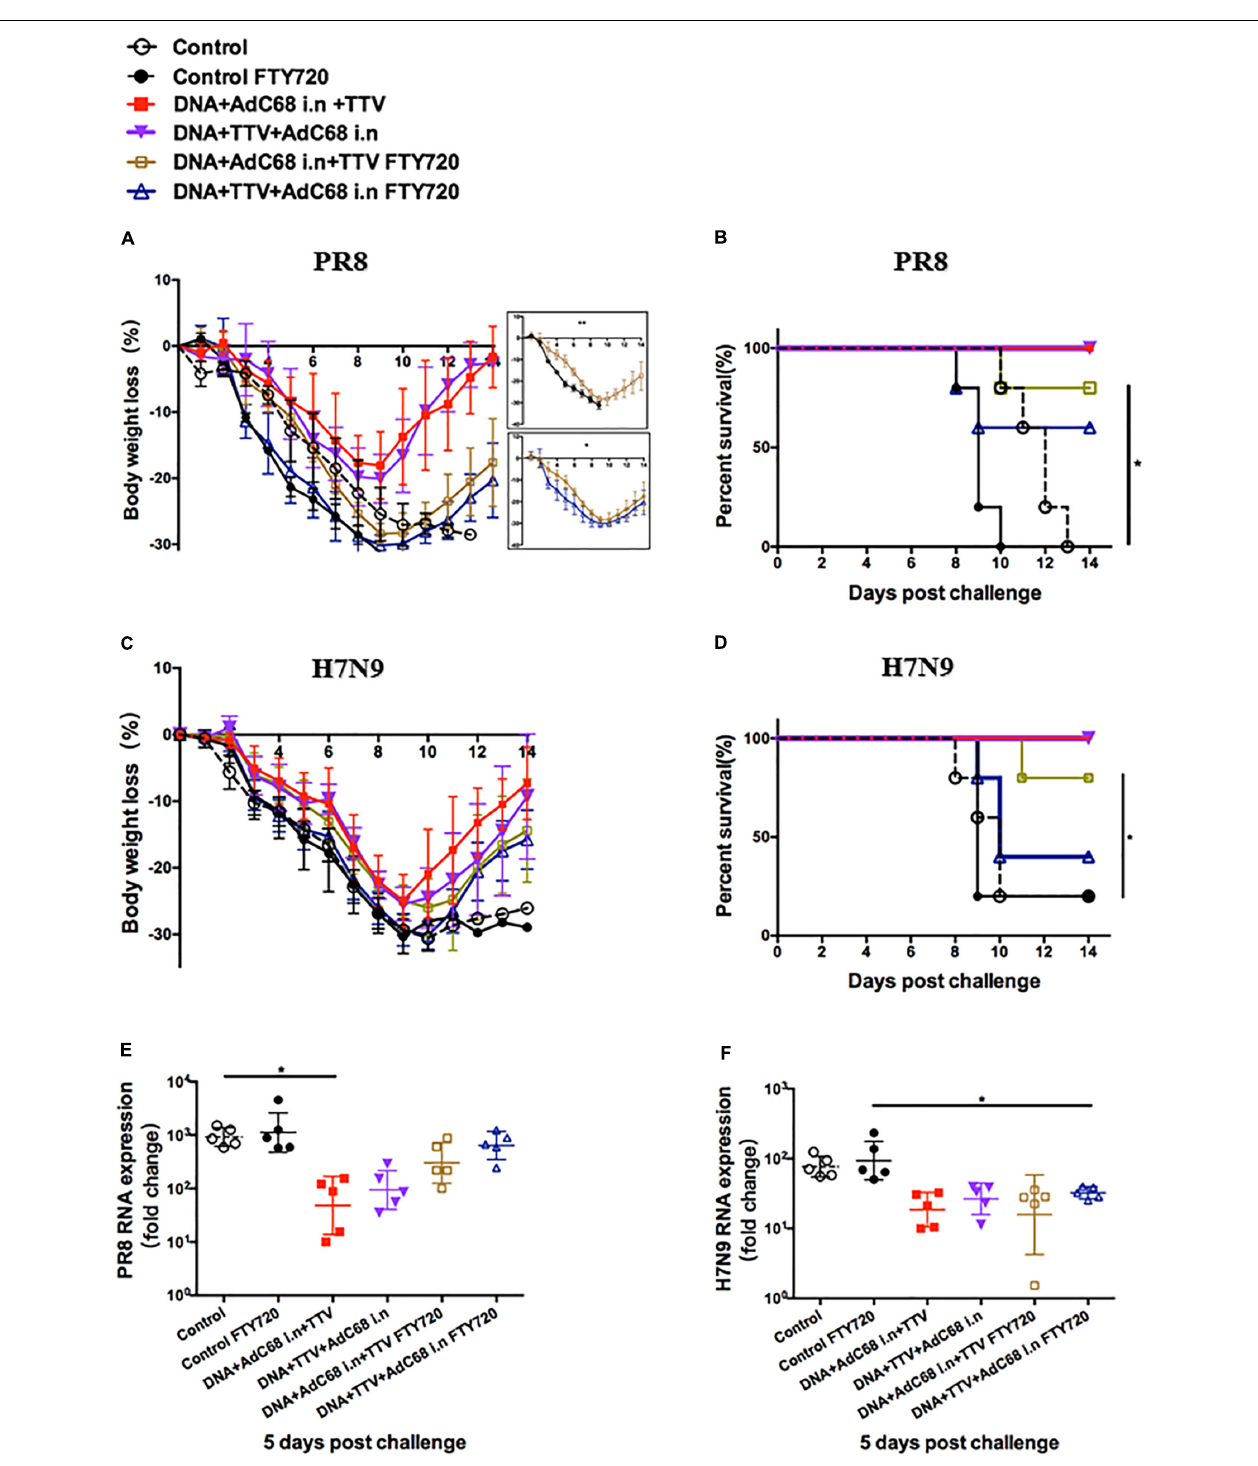
FIGURE 6 | Both respiratory residential and systemic T cells are essential for fully protection. The sequential immunizations and virus challenges of vaccinated mice were essentially performed as described in Figure 5A , except that, where indicated, the mice were exposed ad libitum to drinking water containing 2 µ g/ml of dissolved FTY720 during challenge. Shown are: (A,C) Body weight curve of virus-challenged mice. (B,D) Survival curve of virus-challenged mice. (E,F) Relative lung viral loads in infected mice at day 5 after virus challenge as measured by RT-PCR quantifications of influenza-specific RNA. The error bars represent the SDs. Two-way ANOVA test, Mantel–Cox log rank test and t -test were used to determine difference in weight loss, lethality, and viral load, respectively. ∗∗ p < 0.01; ∗ p < 0.05; n = 5.